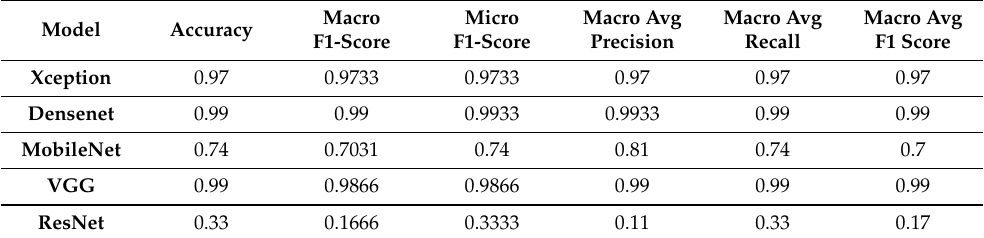
Table 6. Summary of results for human reticulocyte dataset.